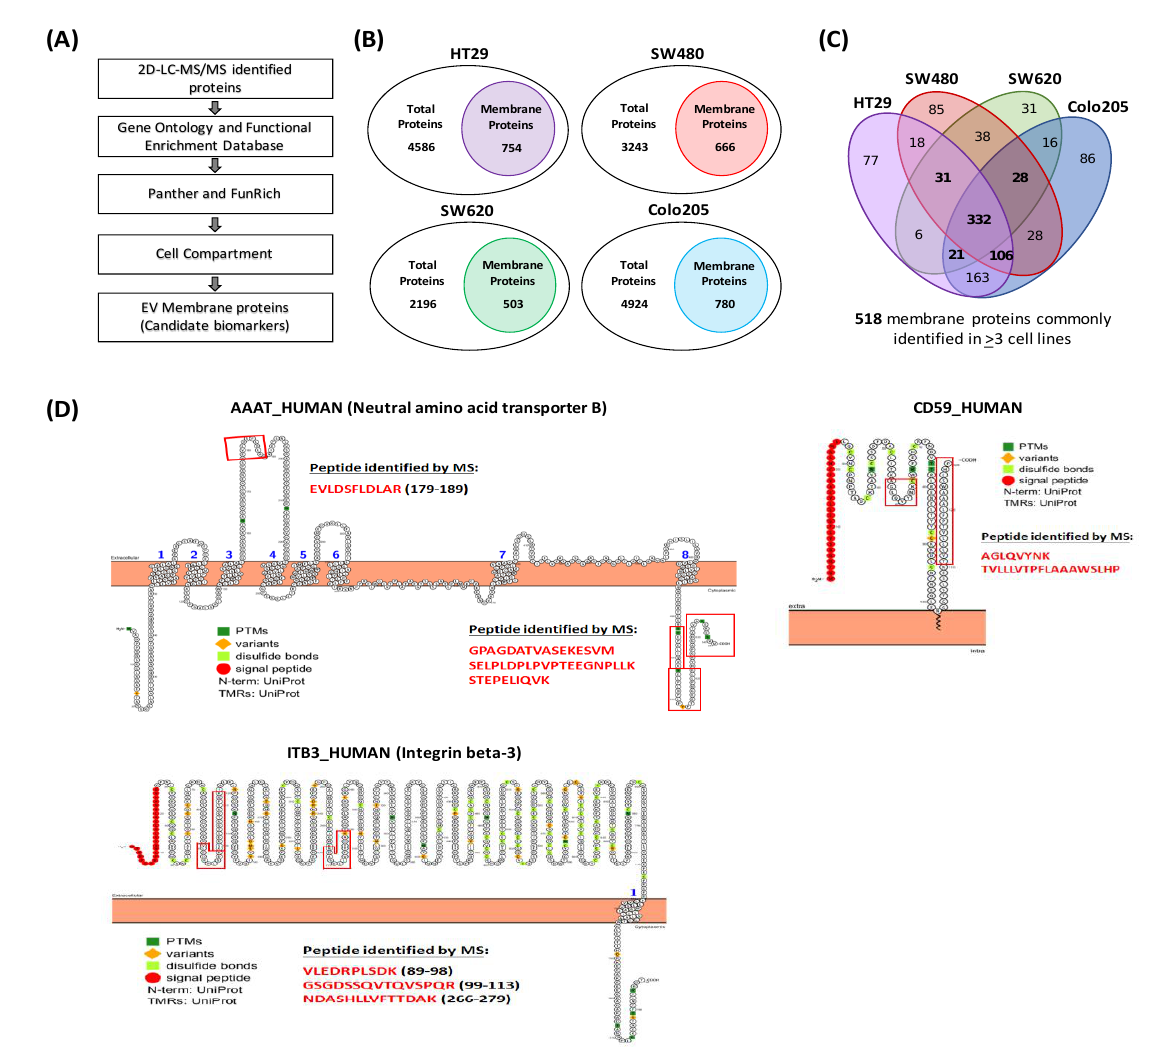
Figure 3. Identification of EV membrane proteins. ( A ) Workflow for the identification and selection of EV membrane proteins. The identified proteins from LC-MS/MS were sorted with Panther (Gene Ontology) and Funrich using Exocarta and Vesiclepedia databases for cell compartmentalization. ( B ) Total MS-identified proteins and membrane proteins associated with each of the four CRC cell lines, as predicted by GO databases. ( C ) Venn diagram showing the overlap of EV membrane proteins found in the four CRC cell lines. ( D ) Selected examples for topological analysis of target membrane proteins. MS-detected peptides for each identified protein are denoted by red